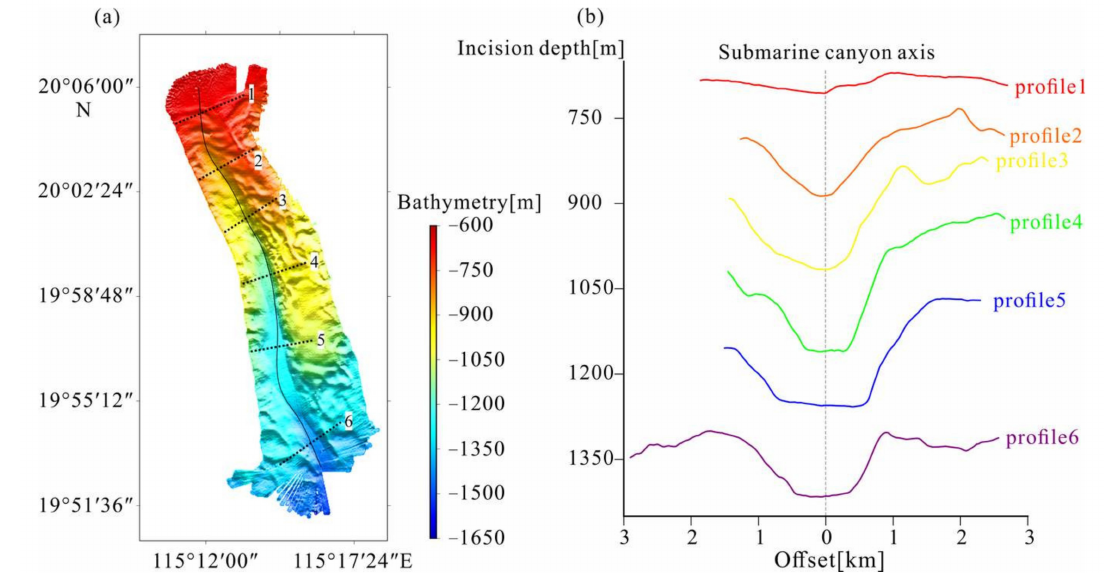
Figure 6. ( a ) Bathymetric variations of the Shenhu canyon. The solid black line represents the central axis of the canyon. The dotted black lines represent the vertical cross sections at the different segments. The location of the Shenhu canyon in the South China Sea is marked in Figure 1a. ( b ) Geometry of the Shenhu canyon along six profiles. The V-shape geometry can be observed in profiles 2–3 at the top segment of the canyon. Meanwhile, the U-shape incision is shown in profiles 4–6 at the bottom segment of the